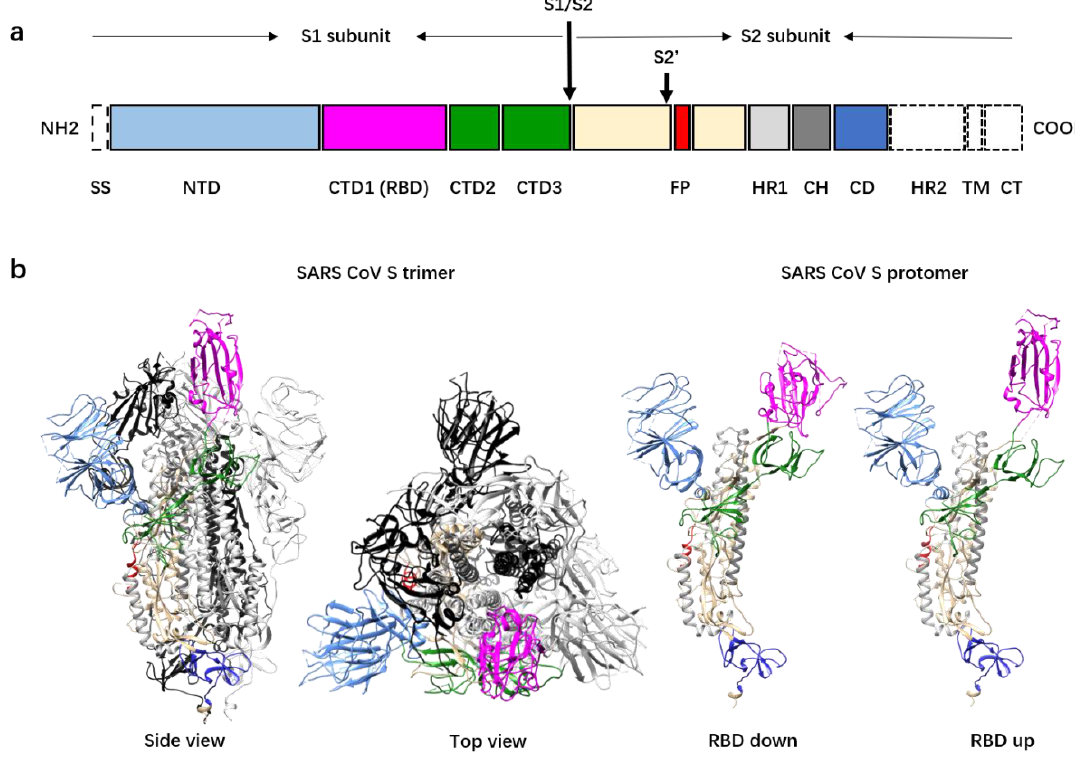
Figure 1. Domain organization and pre-fusion structure of the severe acute respiratory syndrome coronavirus (SARS-CoV) spike (S) protein. ( a ) A schematic diagram showing the primary sequence and domain organization of the SARS-CoV S protein. The domains and subunits of S are indicated and highlighted with different colors. Domains not shown in the 3D structure (in panel b ) are colored white. SS, signal sequence; NTD, N-terminal domain; CTD1/2/3, C-terminal domains 1/2/3; RBD: receptor binding domain; S1/S2: S1/S2 protease cleavage site; S2′: S2′ protease cleavage site; FP: fusion peptide; HR1: heptad repeat 1; CD: connector domain; HR2: heptad repeat 2; TM: transmembrane domain; CT: cytoplasmic tail. ( b ) Left panel: Pre-fusion structure of the SARS-CoV S protein trimer with one RBD in the “up” conformation shown in side view and top view. The protomer with the “up” RBD is shown in ribbons colored as in the schematic diagram (panel a ). The other two protomers with the “down” RBDs are colored black and gray. Right panel: Ribbon diagrams showing one RBD “down” protomer and one RBD “up” protomer.